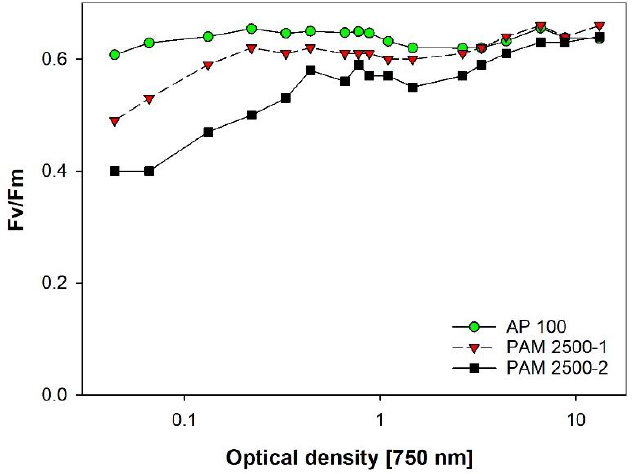
Figure 11. Comparison of Fv/Fm over a wide range of OD obtained with three PAM-fluorescence devices (highest OD of 13 corresponds to DM of 0.84 gL −1 ). Dilution experiment with Chlorella vul- vices (highest OD of 13 corresponds to DM of 0.84 gL − 1 ). Dilution experiment with Chlorella vulgaris garis cultivated in BG11 full medium. cultivated in BG11 full medium.